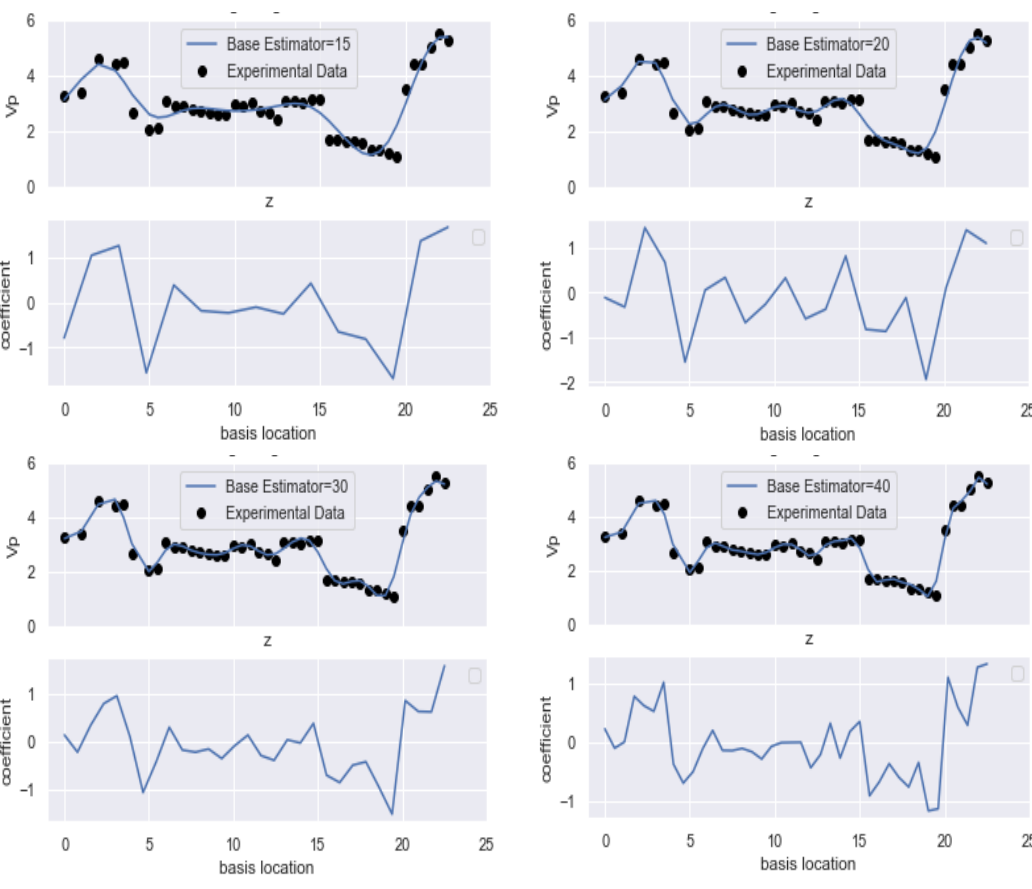
Figure 7. The regularised coefficients of adjacent Gaussian basis functions (Base Estimator = 15,20,30,40) for the prediction plots